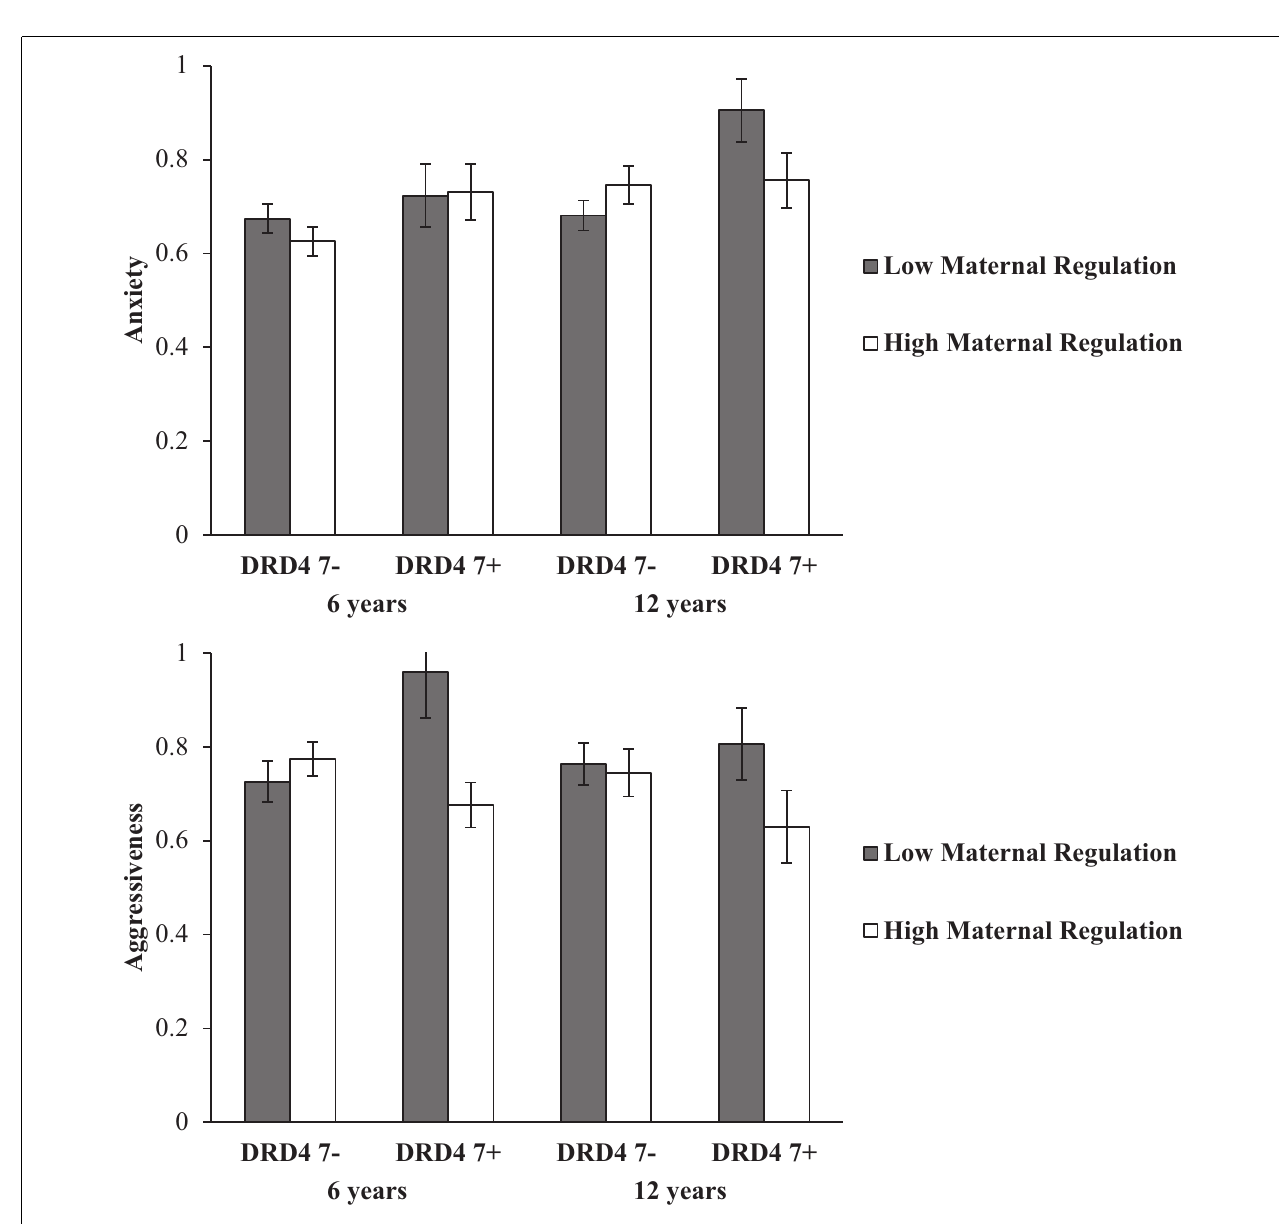
FIGURE 2 | Children’s Means (and SE) in anxiety and aggressiveness according to DRD4 polymorphism and maternal regulation (Scores are lineary transformed by adding 1 to improve